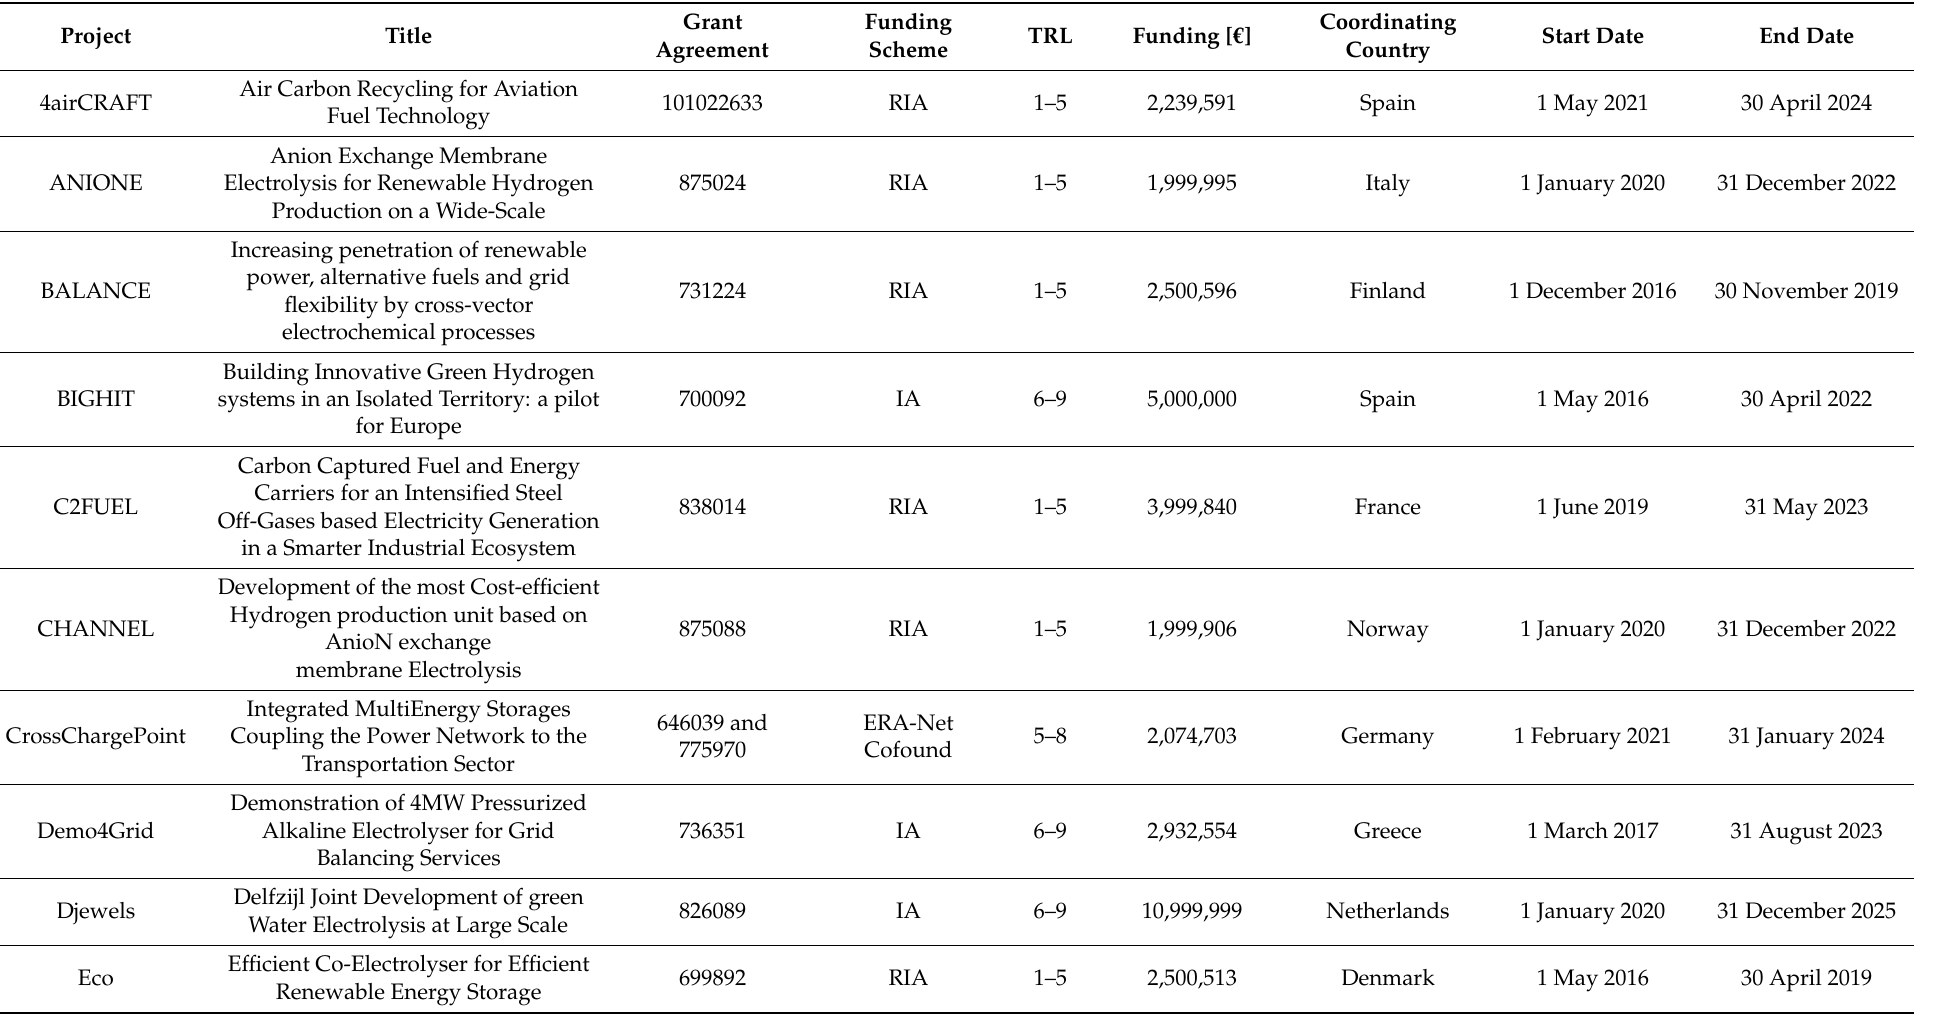
Table A1. General information on the selected projects funded by the Horizon 2020 Programme. (n/a = not applicable).